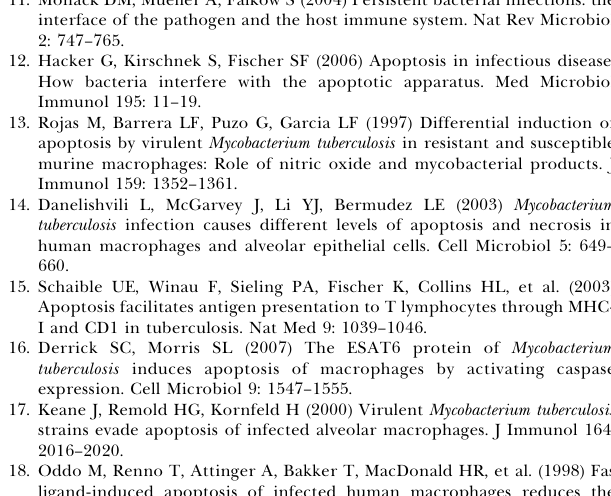
Figure S1. Representative Lung Sections of Infected and Uninfected SCID Mice Found at doi:10.1371/journal.ppat.0030110.sg001 (27.6 MB PPT). Figure S2. Insert of Cosmid J21